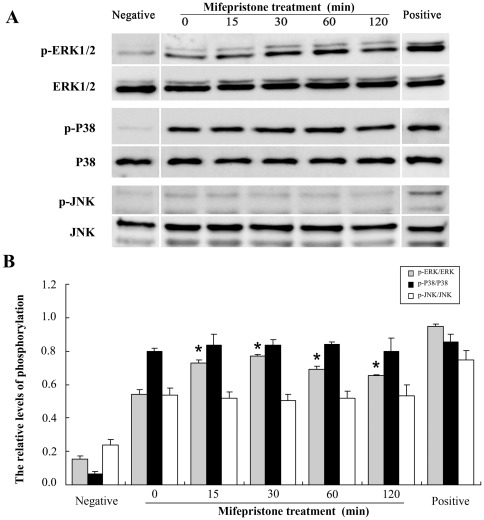
Effects of mifepristone on the phosphorylation level of MAPK in uNK cells.A, a representative immunoblot is shown after the treatment of uNK cells with mifepristone (1.0 µM) for 0, 15, 30, 60, and 120 min. Uterine NK cells were isolated and cultured in the medium without IL-2 for 12 h as a negative control of MAPK/ERK activation. In the drug treatment group, uNK cells were cultured in the medium supplemented with IL-2. Uterine NK cells were cultured in the medium with IL-2 and IL-15 for 15 min as a positive control. Immunodetection of MAPK members used specific antibodies for phosphorylated and total proteins of ERK1/2, P38 and JNK. B, densitometric scans of triplicate blots are shown. Experiments were independently repeated 3 times in each group. Data were analyzed using ANOVA and expressed as means ± SEM. *, P<0.05.